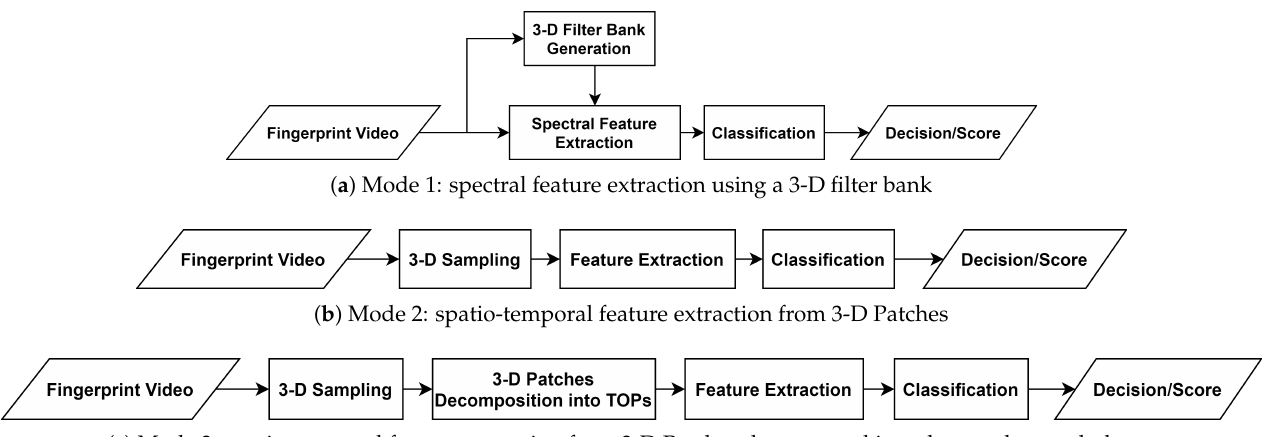
Figure 2. Proposed PAD scheme in different modes.